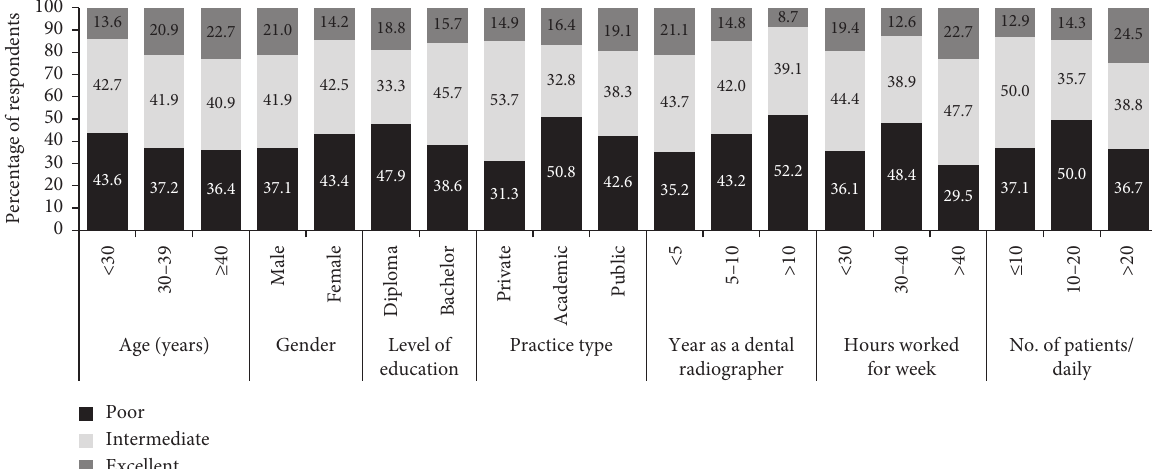
Figure 2: The overall level of compliance with infection control measures for subgroups of participants according to sociodemographic and professional characteristics ( N �